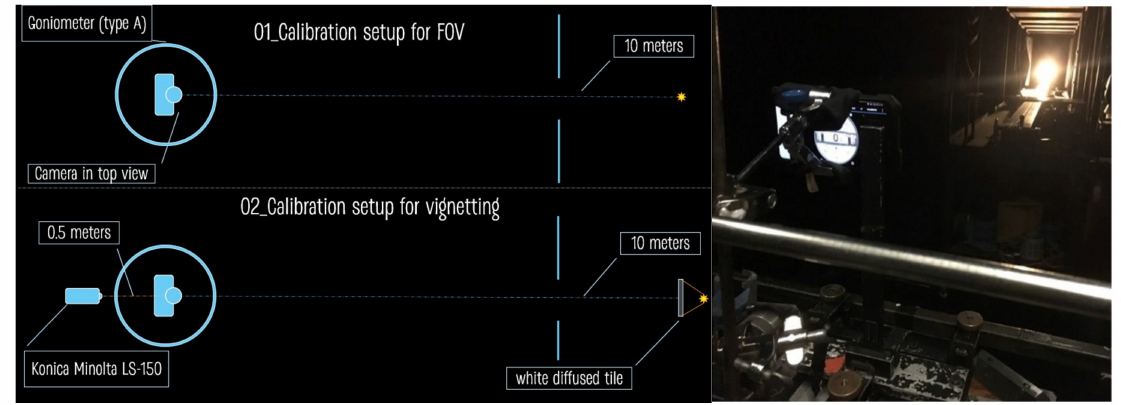
Figure 9. ( Right ) Measurement setup diagram; ( Left ) Alignment between camera / phone device and the light source using a Goniometer (type